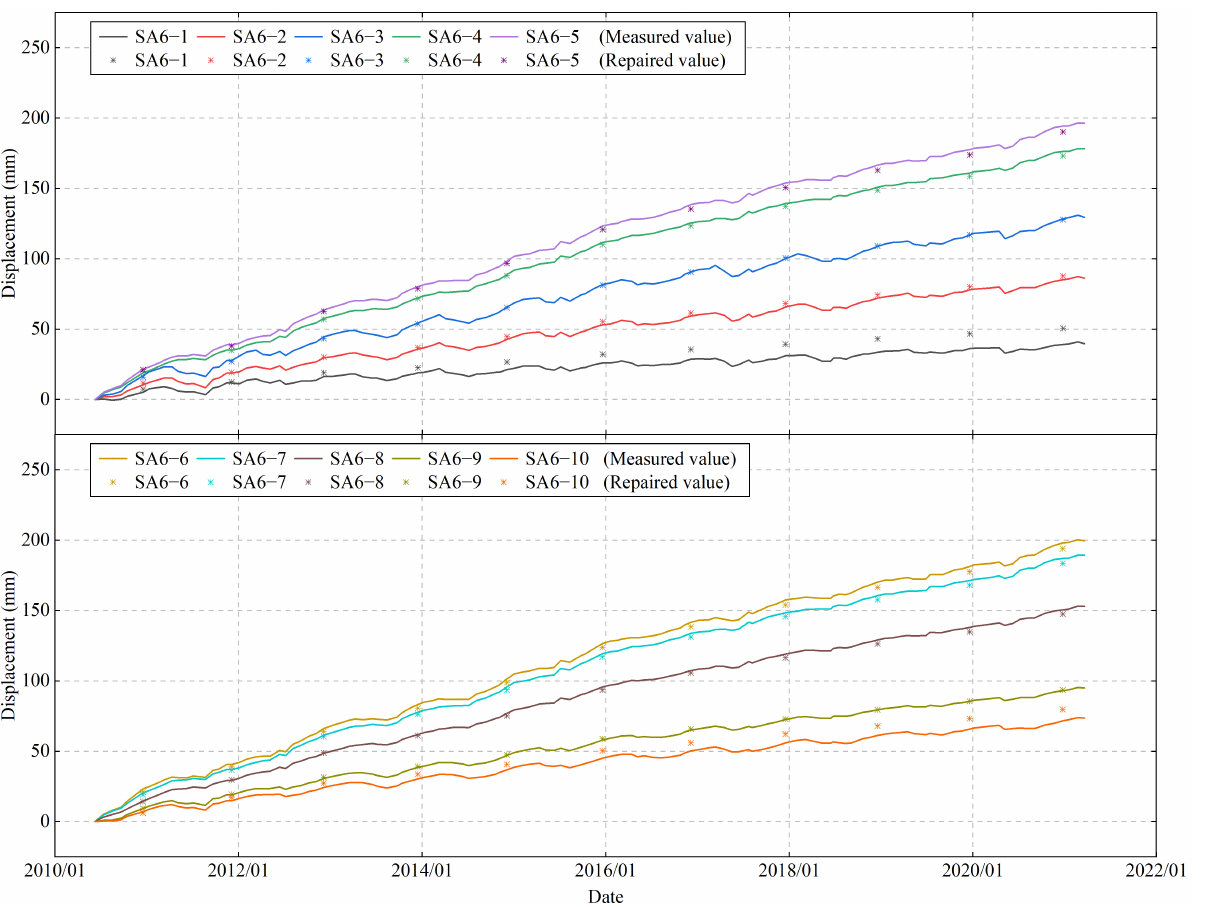
Figure 5. Results of the variable importance for projection of vertical deformation. For the convenience of comparison and analysis, the aging single–factor, aging temperature two–factor, and aging temperature water pressure three–factor spatial cokriging models were constructed by using the measured values of each measuring point. The single–point error analysis was conducted for the measured values on 24 De- cember 2020, as shown in Table 1. In the environmental variables, the aging is a mono- tonic increasing function, and the water level, temperature and rainfall are all periodic